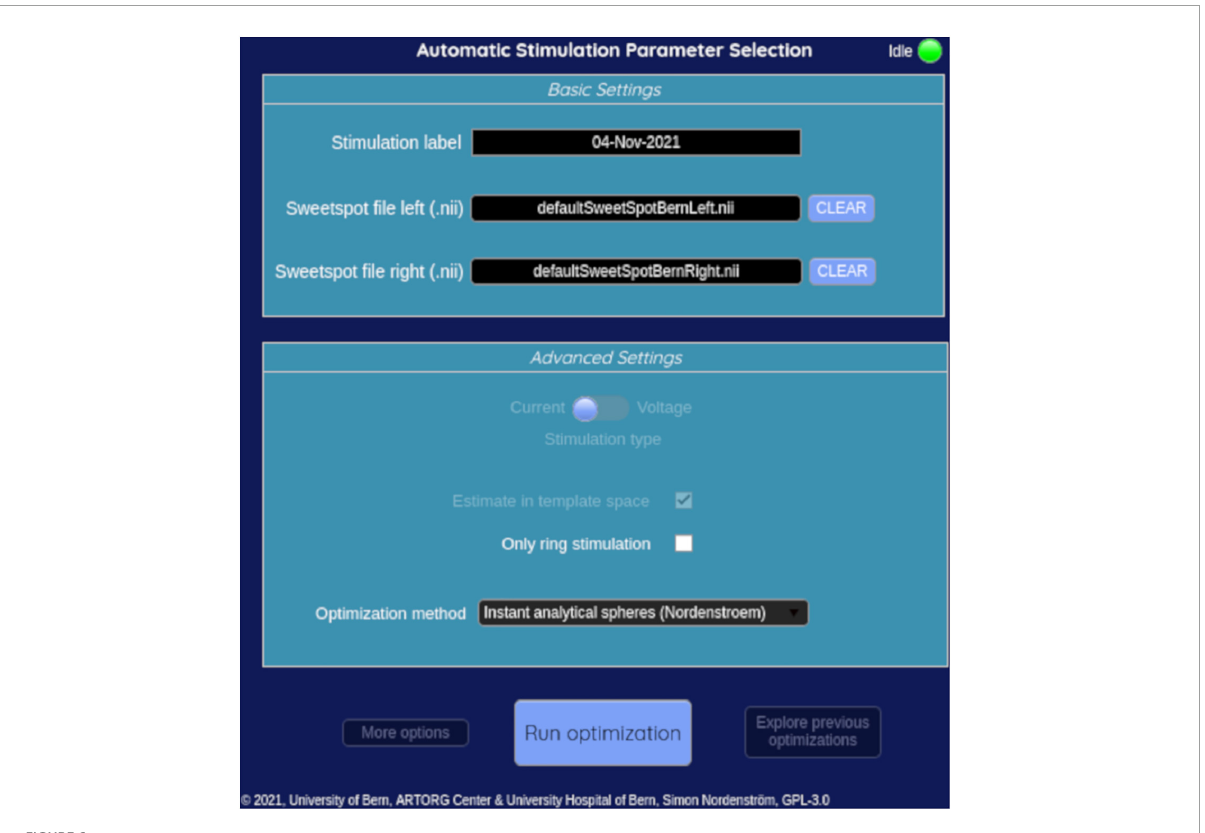
FIGURE6 Input window of the graphical user